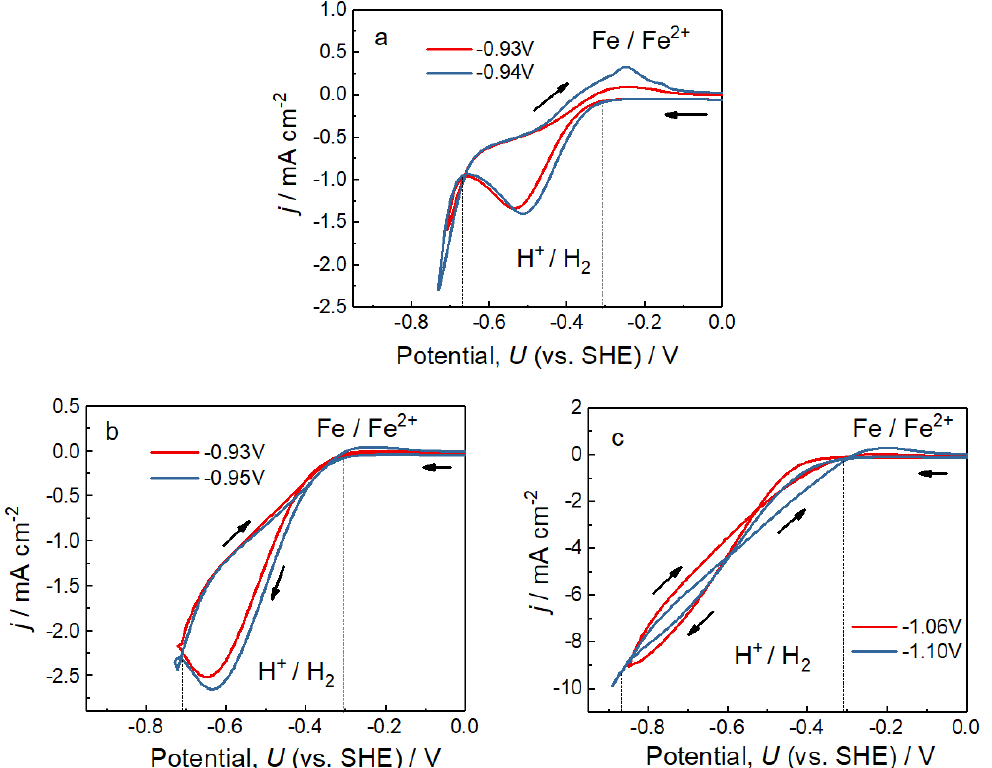
Figure 2. Cyclic voltammograms of the cathodic Fe-P deposition depending on the glycine concentration at 20 ◦ C. ( a ) Glycine free; ( b ) 0.11 M Gly; and ( c ) 0.64 M Gly. Table 1. Onset potential of the cathodic Fe-P deposition as a function of the glycine concentration Gly at 20 ◦